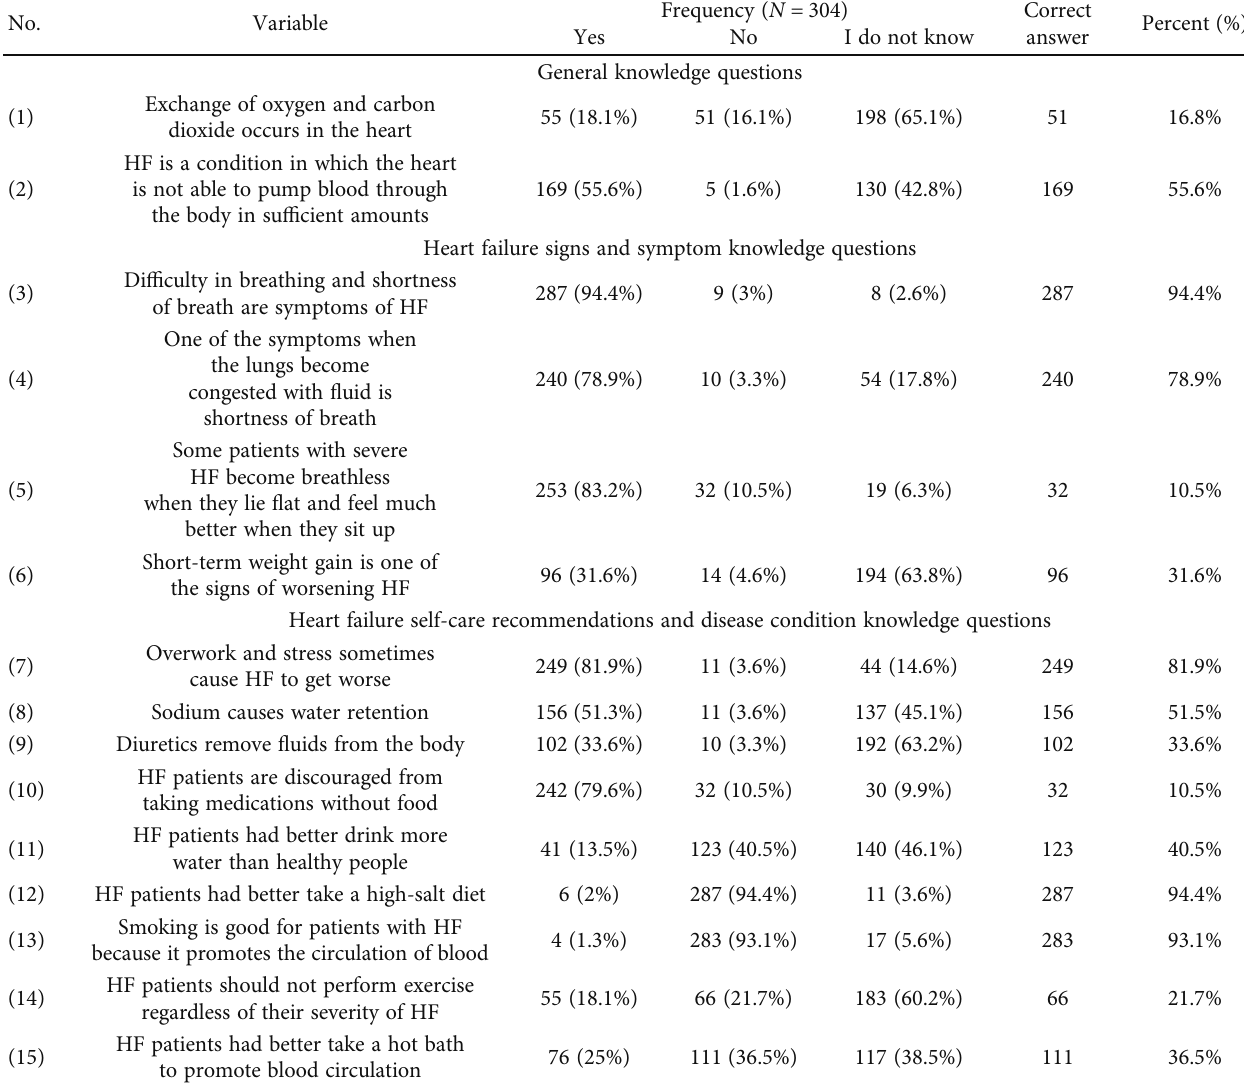
Table 3: Participants ’ knowledge related to heart failure among heart failure patients in West Gojjam Zone public hospitals, Northwest, Ethiopia, 2021 ( N = 304